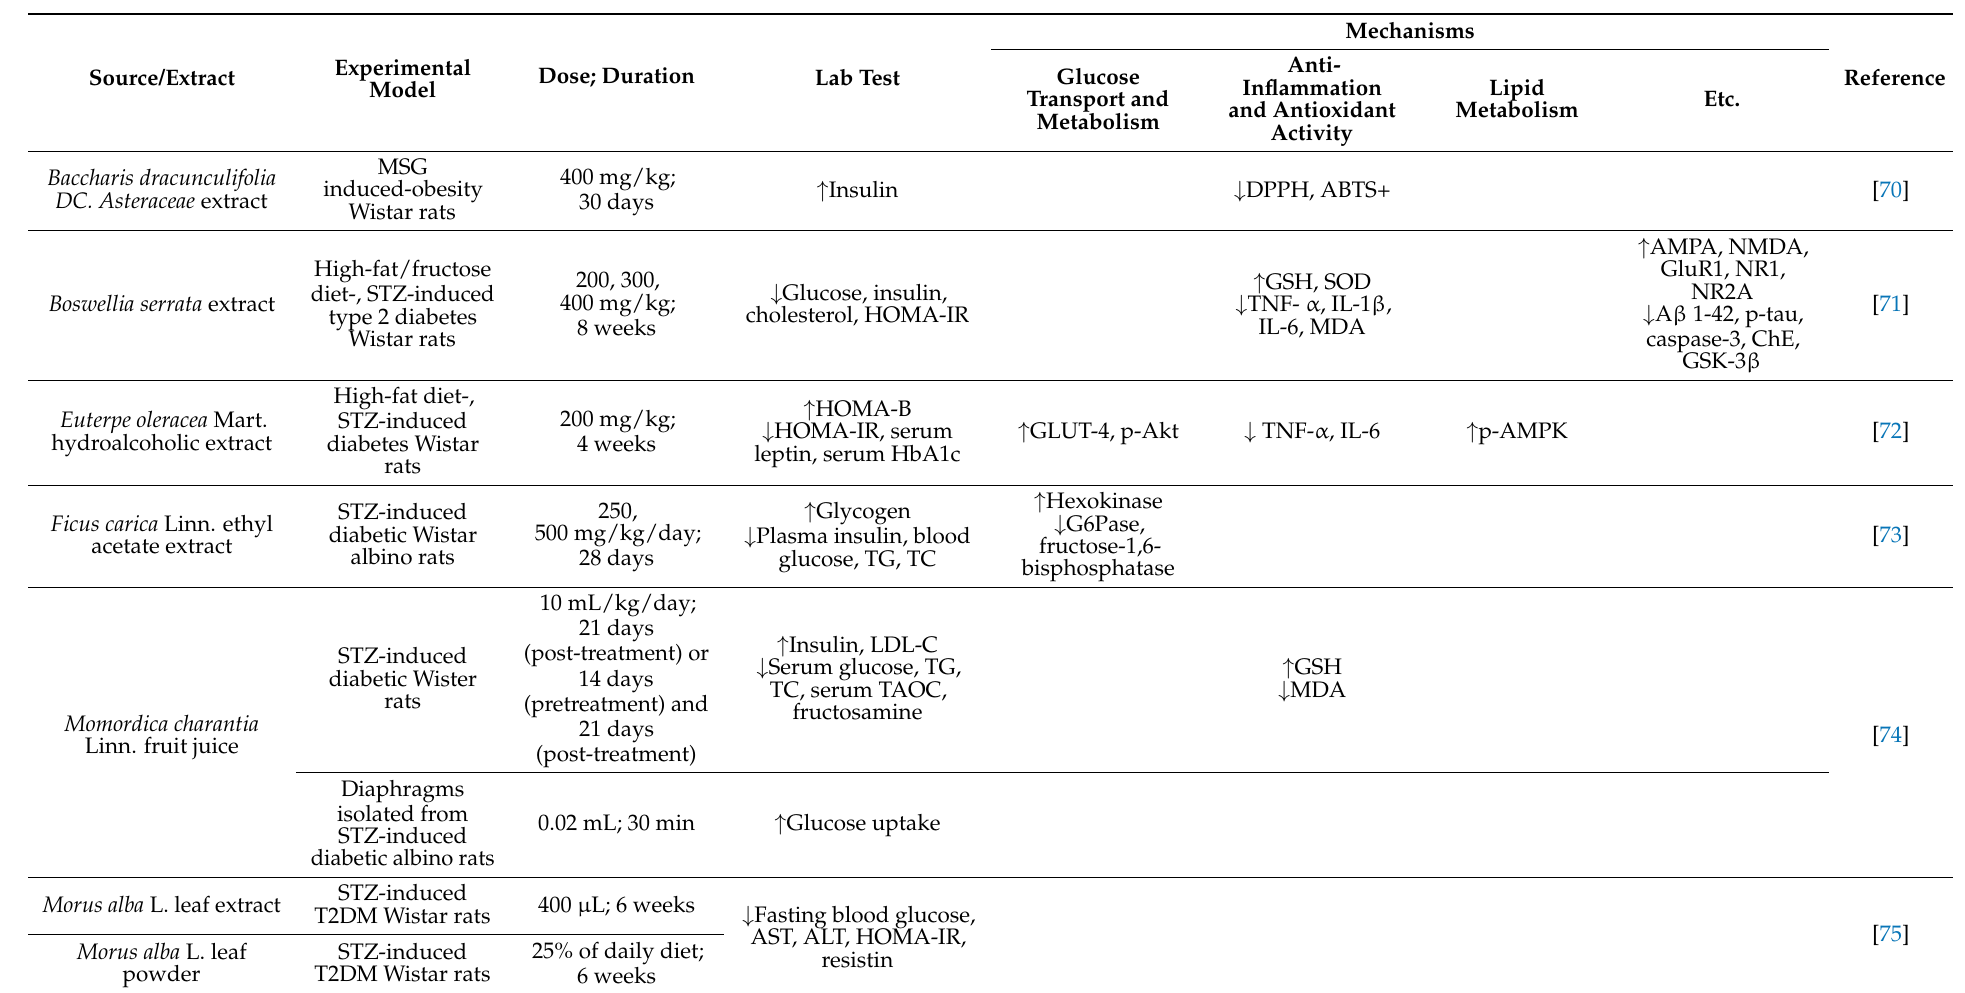
Table 3. In vivo studies—Wistar